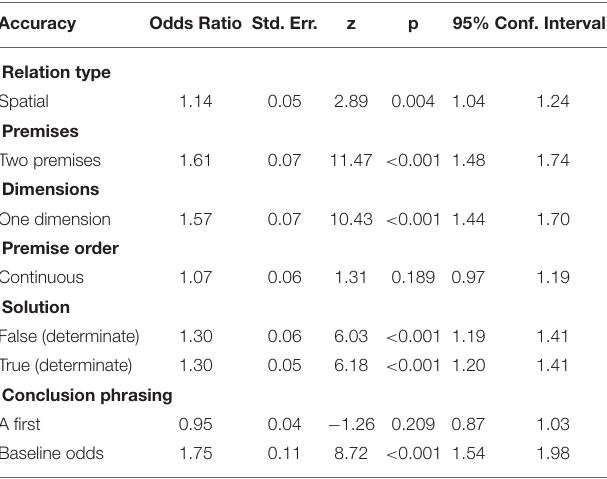
TABLE 3 | Mixed-effects logistic regression model for accuracy (fixed